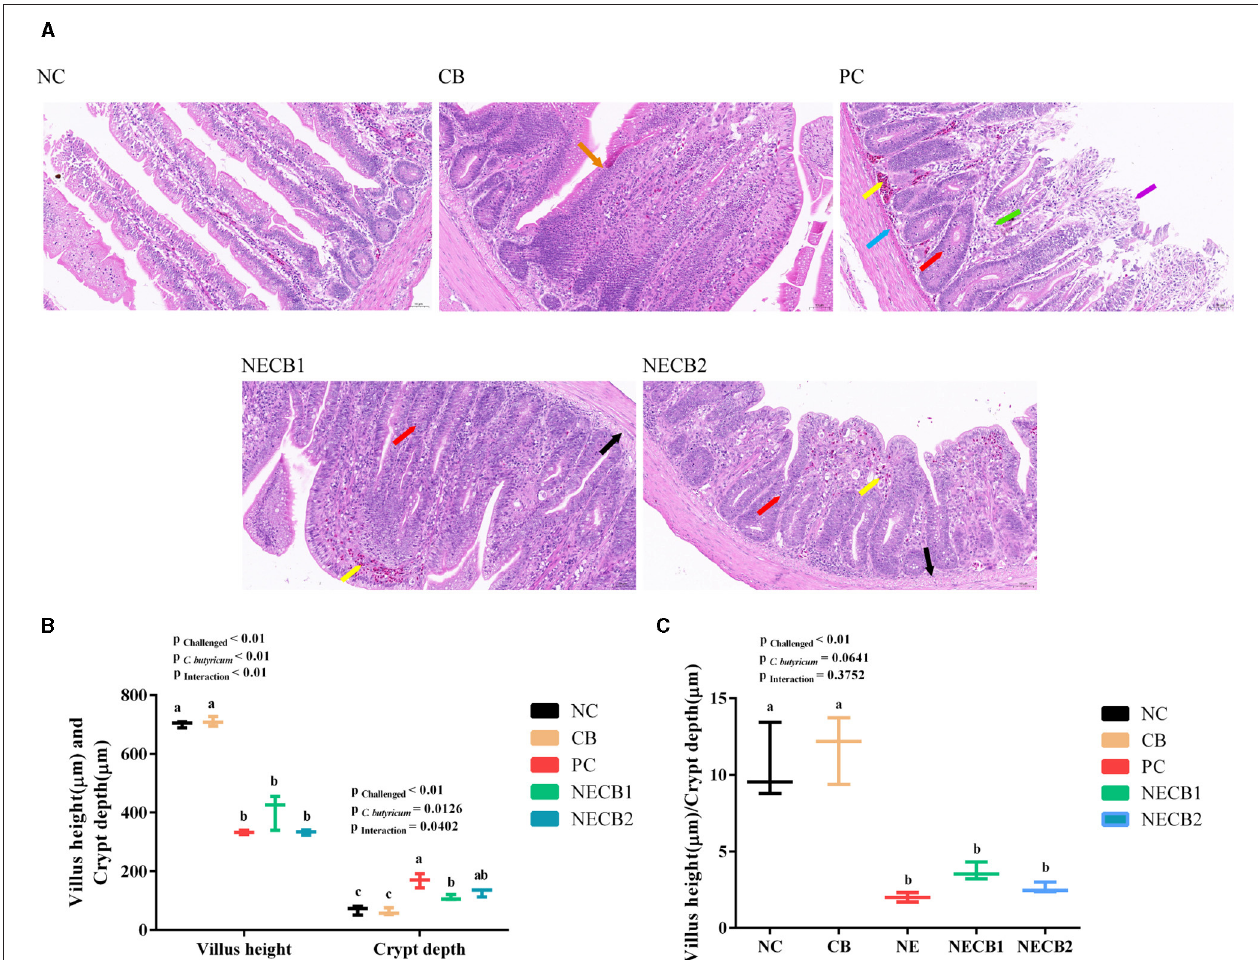
FIGURE 2 | Effect of diet C. butyricum on the pathological section results, villus height, and crypt depth of necrotic enteritis-infected broilers. (A) Pathological section results. Yellow arrow: capillary congestion; red arrow: inflammatory cell infiltration; black arrow: swelling of mucosal muscularis cells, the cytoplasm is loose and lightly stained or vacuolated; blue arrow: eosinophils; orange arrow: intestinal villi merge; purple arrow: exposed lamina propria; and green arrow: increased diffuse lymphoid tissue. Scale bar = 50 µ m. (B) Villus height and crypt depth. (C) Villus height/crypt depth ratio. Each result represents the mean ± SEM ( n = 3). The different lowercase letters on the figure indicate significant differences ( p <